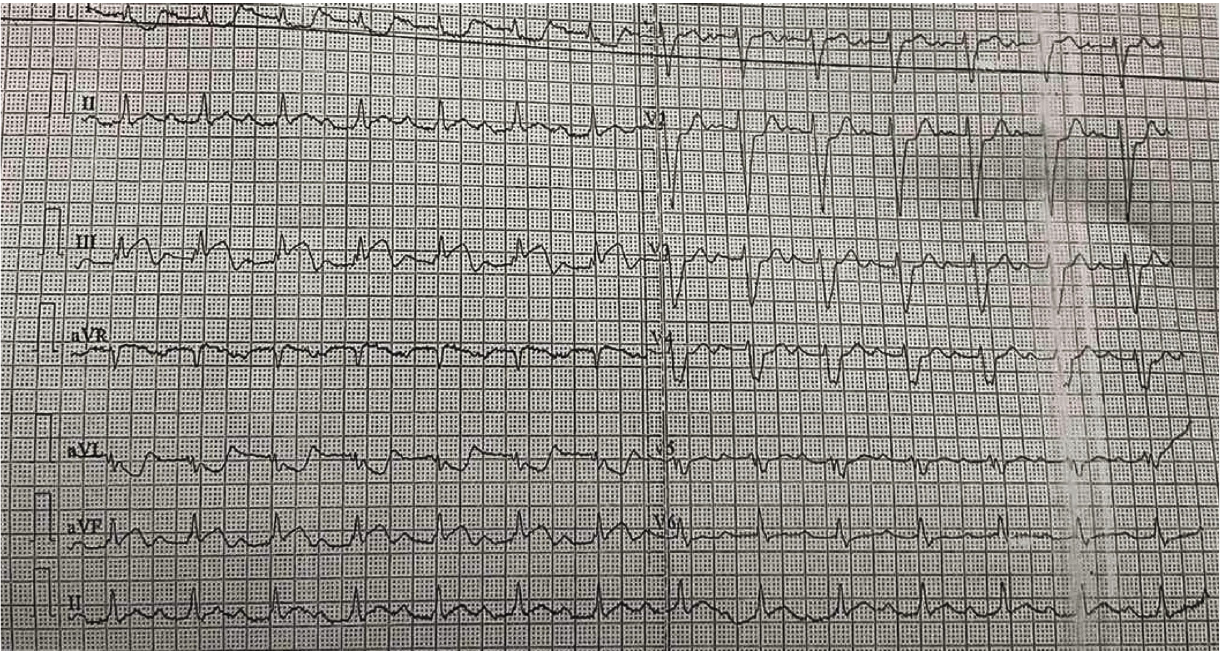
Figure 1: ECG shows ST elevation in inferior leads with fi rst degree heart block.